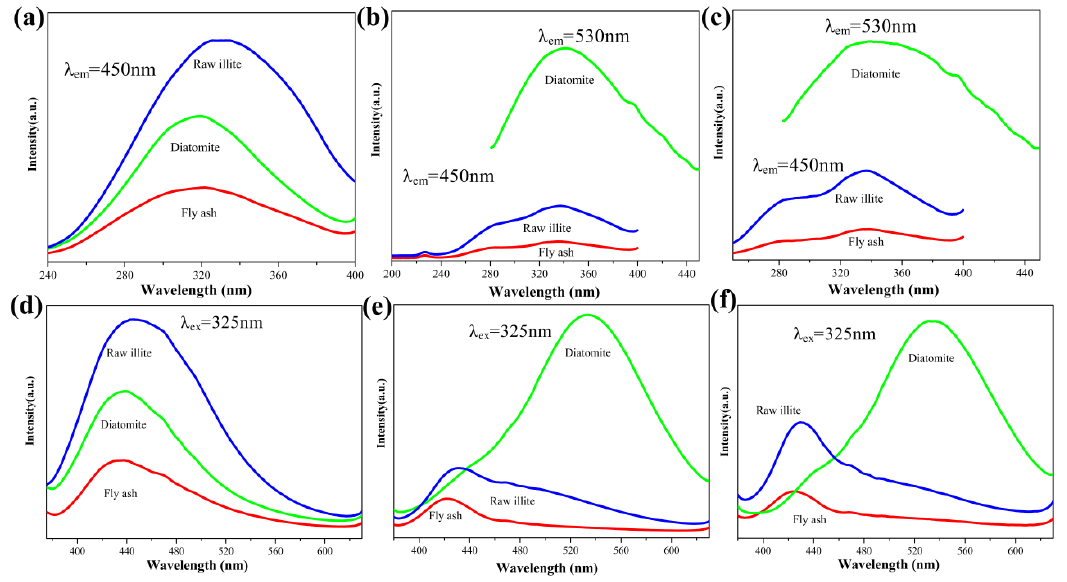
Figure 5. Photoluminescence excitation spectra of the products obtained from different starting materials ( a ) 1350 °C ( b ) 1400 °C ( c ) 1450 °C and emission spectra of the products obtained from different starting materials ( d ) 1350 °C ( e ) 1400 °C ( f ) 1450